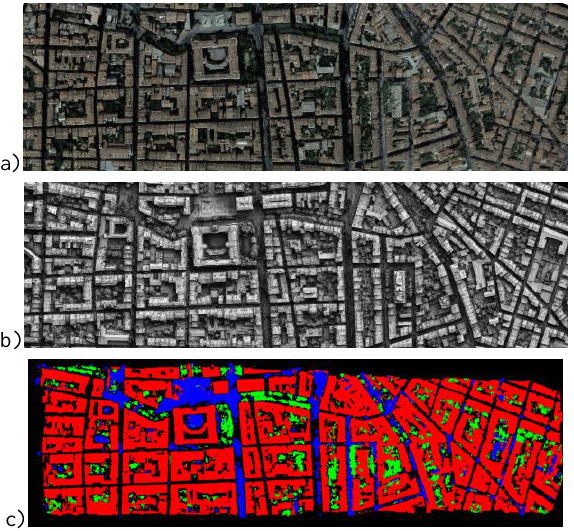
Figure 6: The analysed area over Marseille (a) with the generated DSM (b) and the classification results (c): building (red), roads (blue), vegetation (green) and missing data (black).